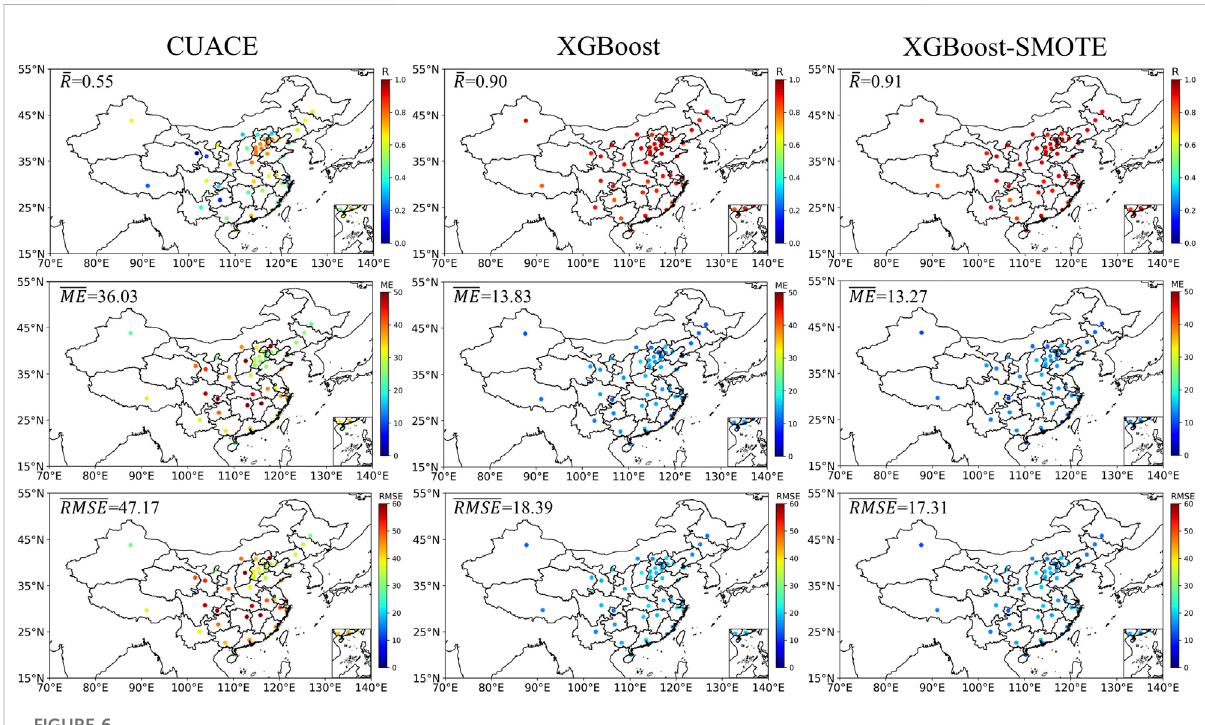
FIGURE 6 Comparison of the 1st-day O 3 forecasting results for the original CUACE, XGBoost, and XGBoost-SMOTE